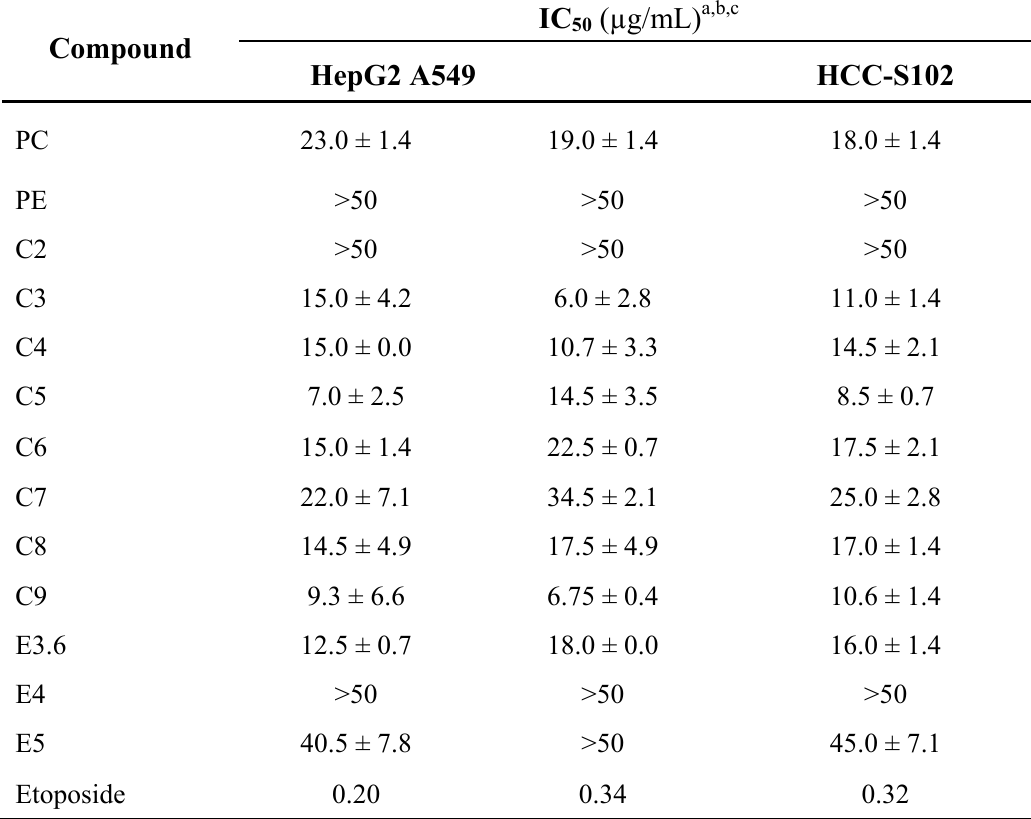
Table 3. Cytotoxic activity of P.